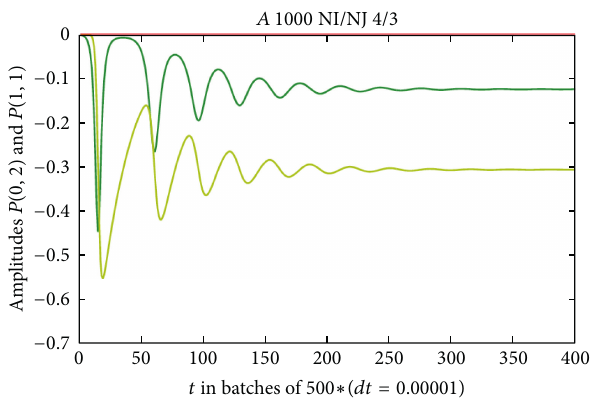
= 1000 . Figure 3: Simulation grids NI × NJ = 7×5 up to 𝑡 = 1.5 . 𝑅 aL